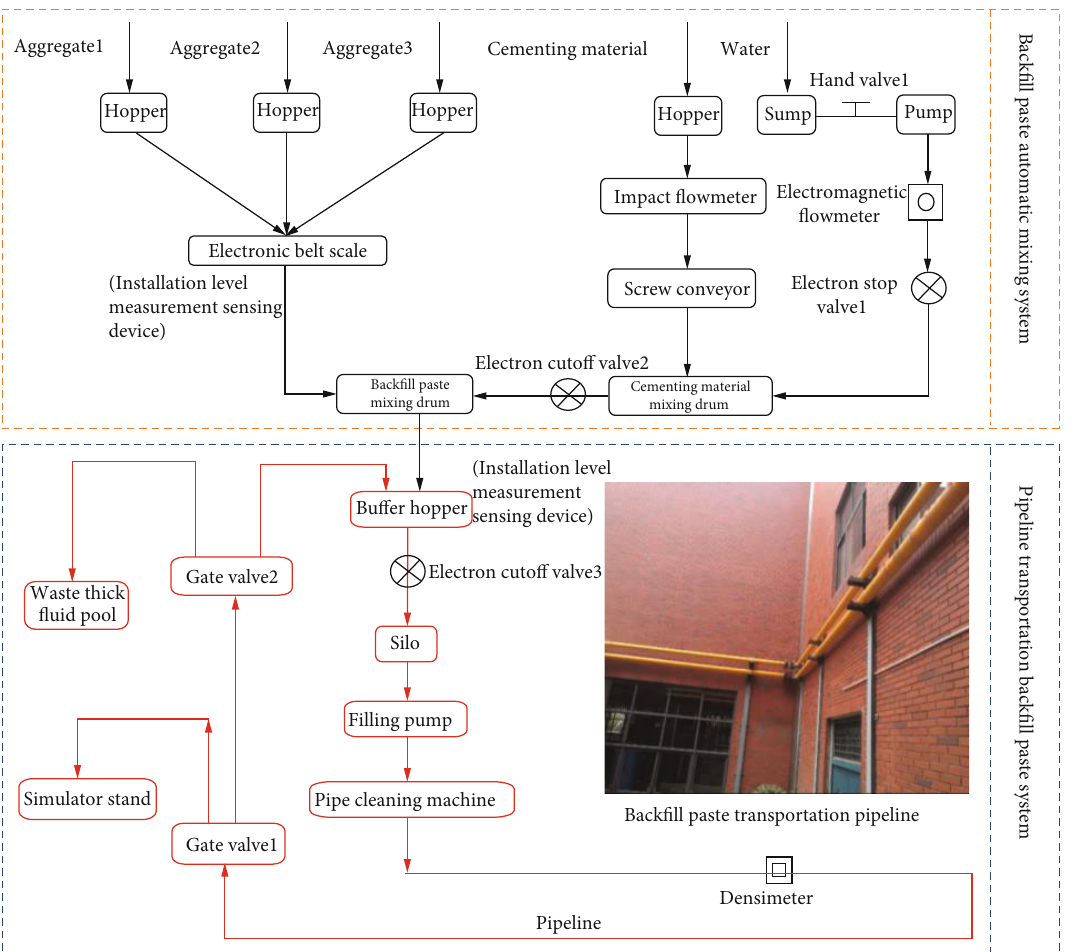
Figure 9: Paste proportioning and pipeline transportation simulation